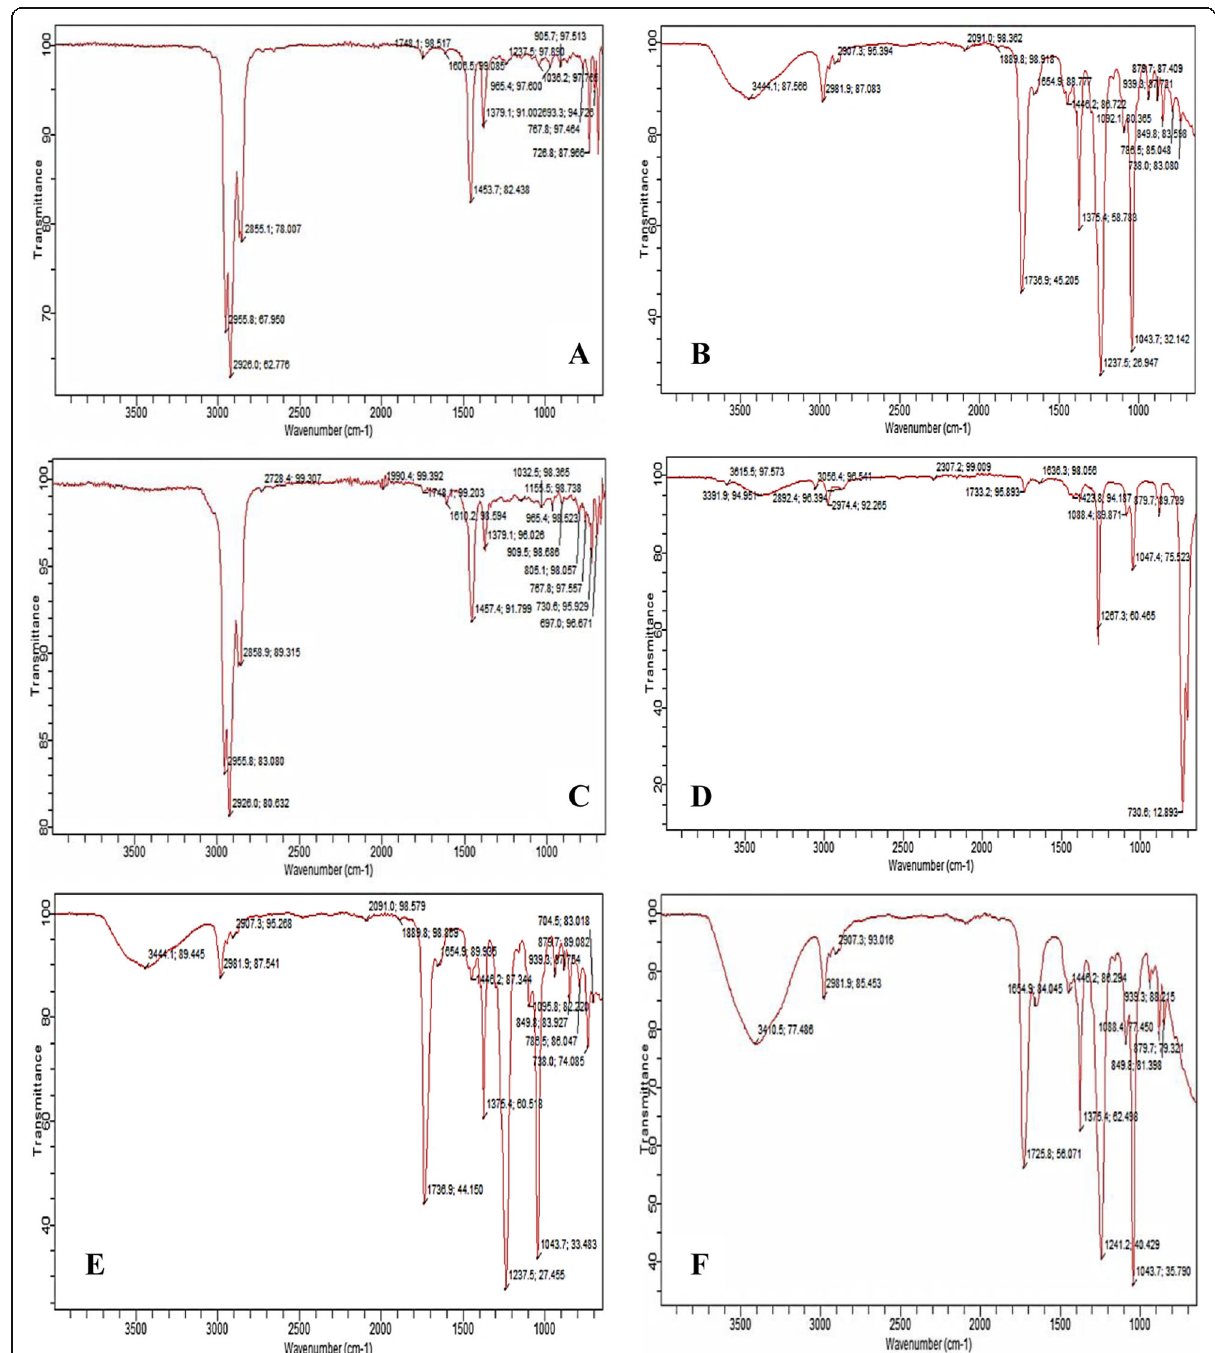
Fig. 5 FT-IR spectra of a petroleum ether extract of A . occidentale . b ethylacetate extract of A . occidentale . c n -Hexane extract of P . guajava . d Chloroform extract of P . guajava . e Ethylacetate extract of P . guajava . f Ethylacetate extract of T .